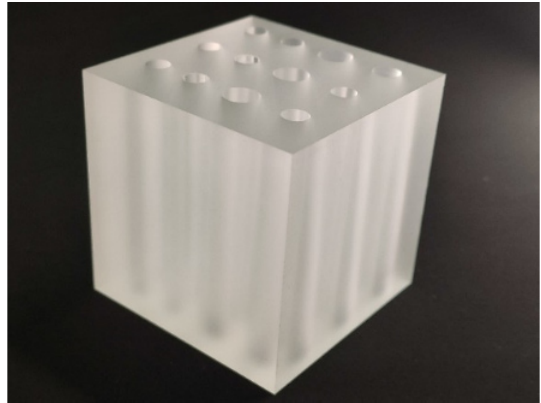
Fig. 1. component (cube - 50 x 50 x 50 mm³) with drilled holes of 50 mm depth